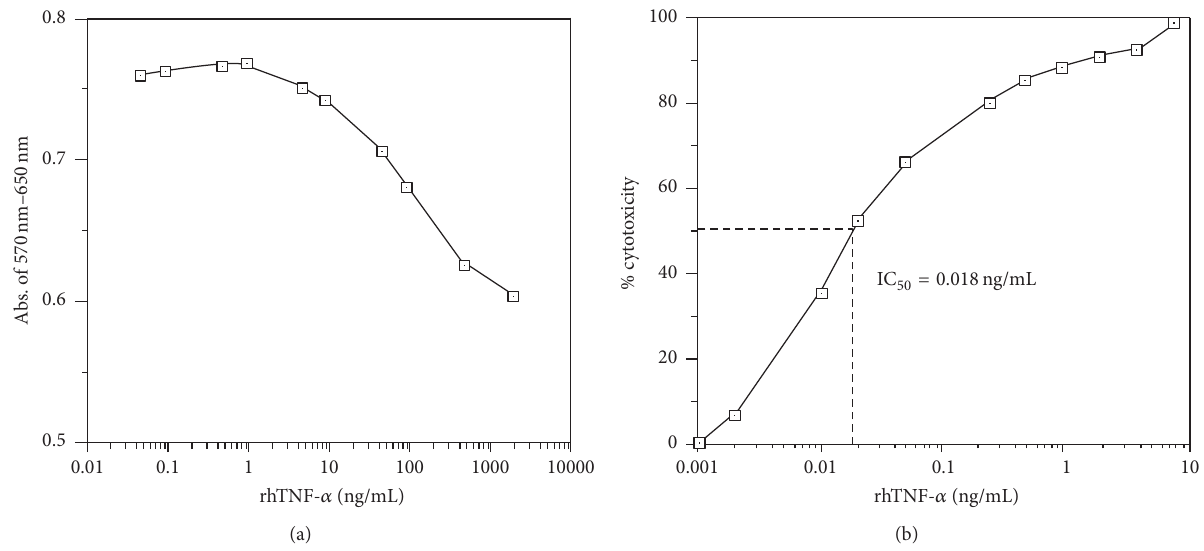
Figure 2: (a) Dose-response curve of human HEp-2 cells in response to rhTNF- 𝛼 . Various concentrations of rhTNF- 𝛼 were diluted with complete RPMI-1640 medium. Details were described in Materials and Methods. Positive control wells containing 200 ng/mL rhTNF- 𝛼 were used as blank. IC 50 of rhTNF- 𝛼 to HEp-2 cells was estimated to be more than 10ng/mL. (b) Dose-response curve of murine L929 fibroblasts in response to rhTNF- 𝛼 . Details of L929 bioassay and MTT stain were described in Materials and Methods. IC 50 of rhTNF- 𝛼 to L929 cells was estimated to be 0.18 ng/mL.